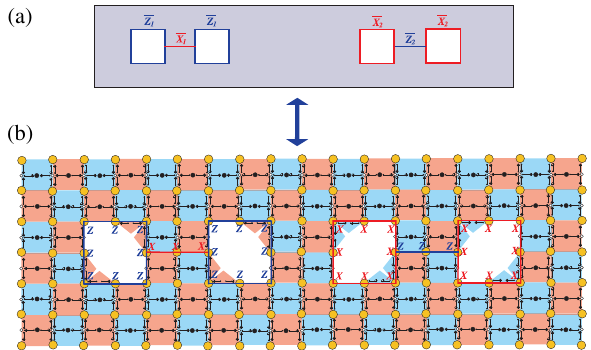
FIG. 21. (a). On the left, there is a double Z -cut logical qubit consisting of two smooth whole defects; on the right, there is a double X -cut logical qubit consisting of two rough hole defects. (b) The explicit construction of the two types of logical qubits with hole defects on the heavy-square topological distance in this case is d ¼ 3 , i.e., the length of the shortest logical string. Again, the flag decoder can correct up to bð d − 1 Þ = 2 c faults in this case as well. Braiding of a Z -cut defect around another X -cut defect implements a logical CNOT gate.